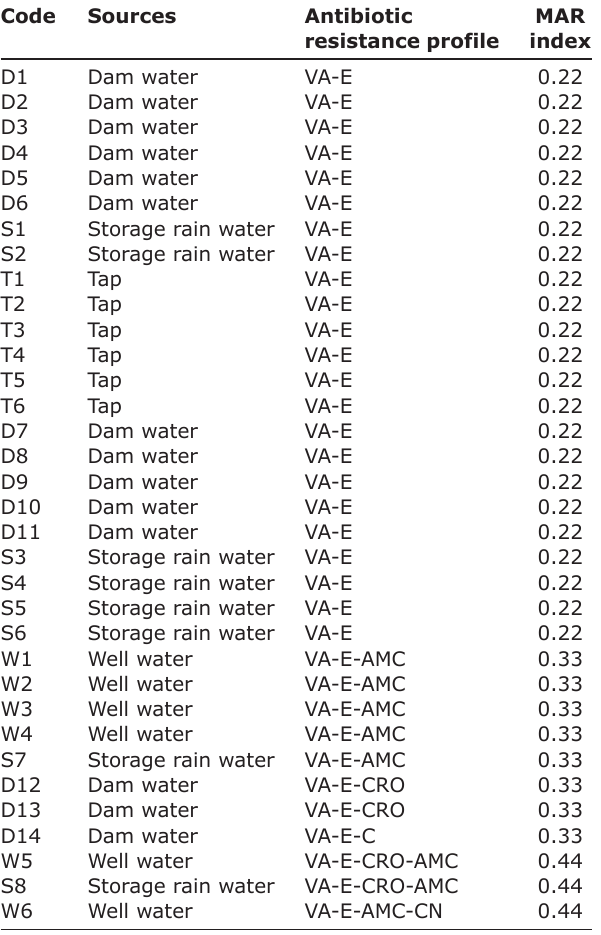
Table-3: Antibiotic resistance pattern of the Salmonella species. Code Sources Antibiotic resistance